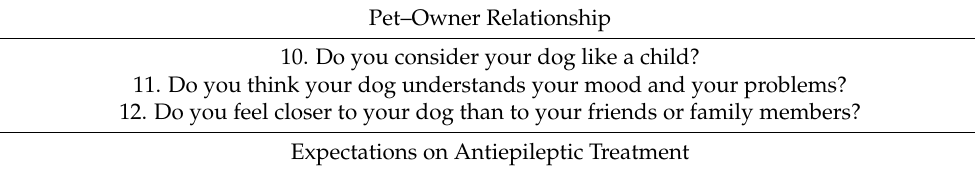
Table 1. Questions 10 to 49 of the